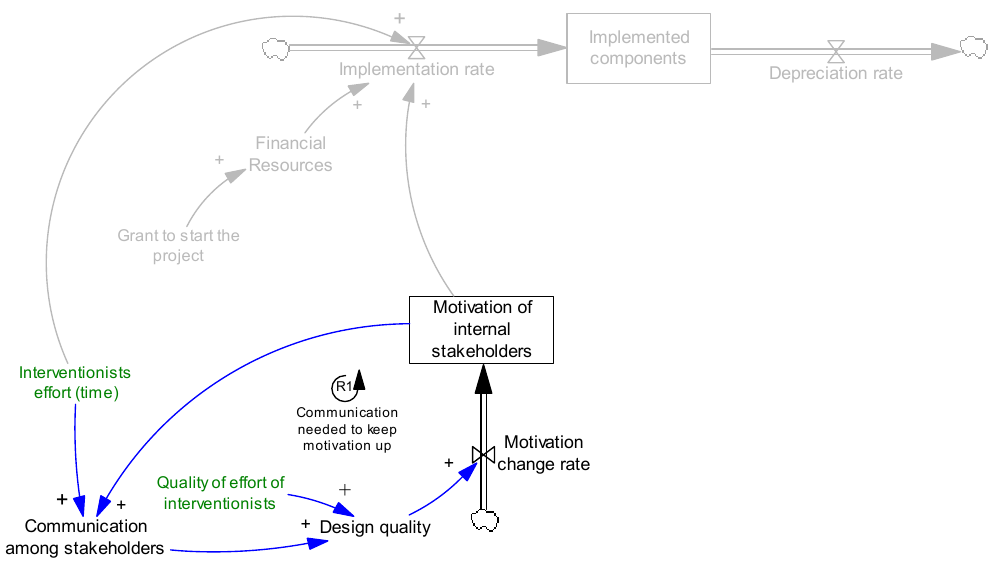
Figure 3. Effect of communication on motivation. R1 presents a reinforcing feedback loop.